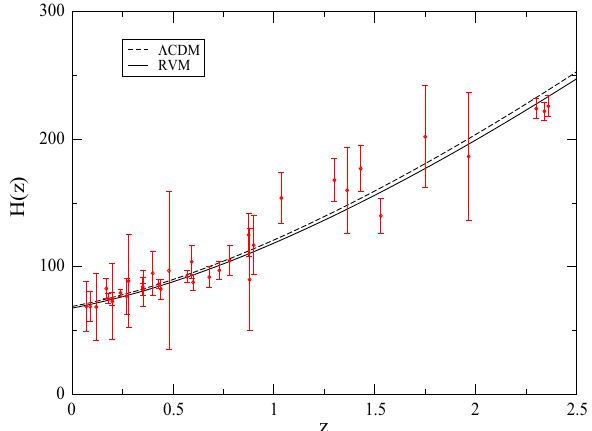
Fig. 1 Data on the Hubble rate H ( z ) (in km/s/Mpc) at different red- shifts versus the theoretical Hubble function of the running vacuum model (RVM) in the G = const. case ( solid line ) and the (cid:2) CDM ( dashed line ); see the text. The value of the RVM vacuum parameter is fixed at ν = 0 . 001, as this is the order of magnitude obtained in the joint likelihood fit to the overall SNIa+BAO+H(z)+LSS+BBN+CMB data performed in [59–61] (see references therein)